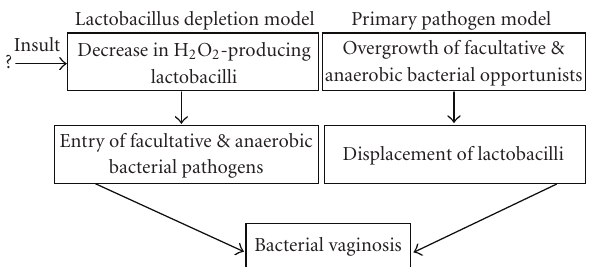
Figure 1: Competing models for the pathogenesis of BV. At least 2 models exist to explain the pathogenesis of BV. The lactobacillus depletion model suggests that there is a decrease in hydrogen peroxide producing lactobacilli as the primary event that allows for the overgrowth of facultative anaerobes resulting in BV. The primary pathogen model suggests that the entry of facultative anaerobes causes the displacement of lactobacilli thereby resulting in